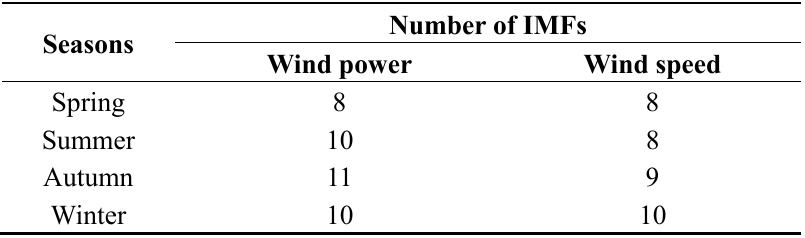
Table 3. Numbers of IMFs extracted from the wind power and speed time series during the four